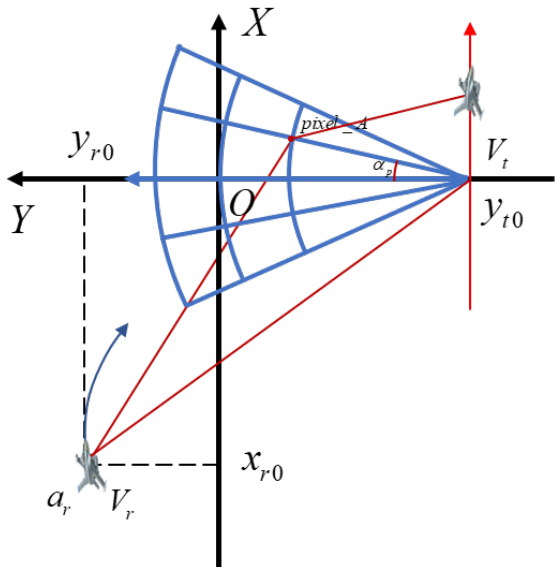
Figure 7. Slant range from transceiver platform to imaging grid